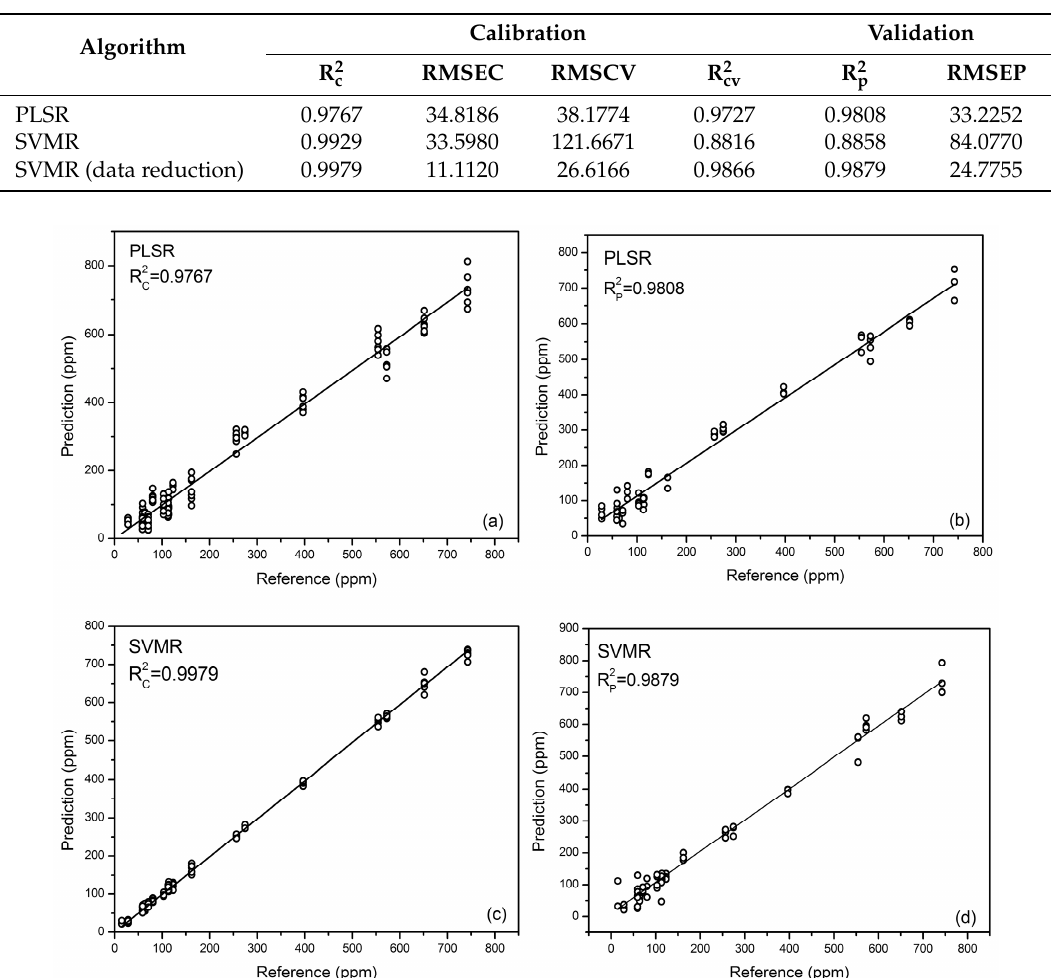
Figure 7. Calibration and prediction for multivariate analysis. ( a ) The calibration result of PLSR; ( b ) the prediction result of PLSR; ( c ) the calibration result of SVMR; and ( d ) the prediction result of SVMR.